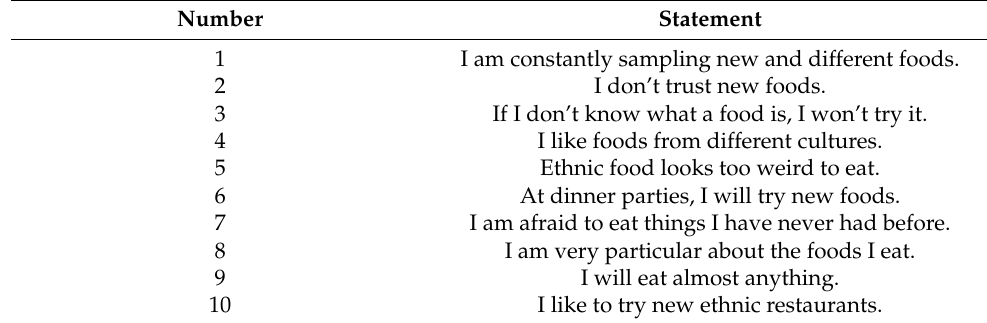
Table 2. The Food Neophobia Scale (FNS).